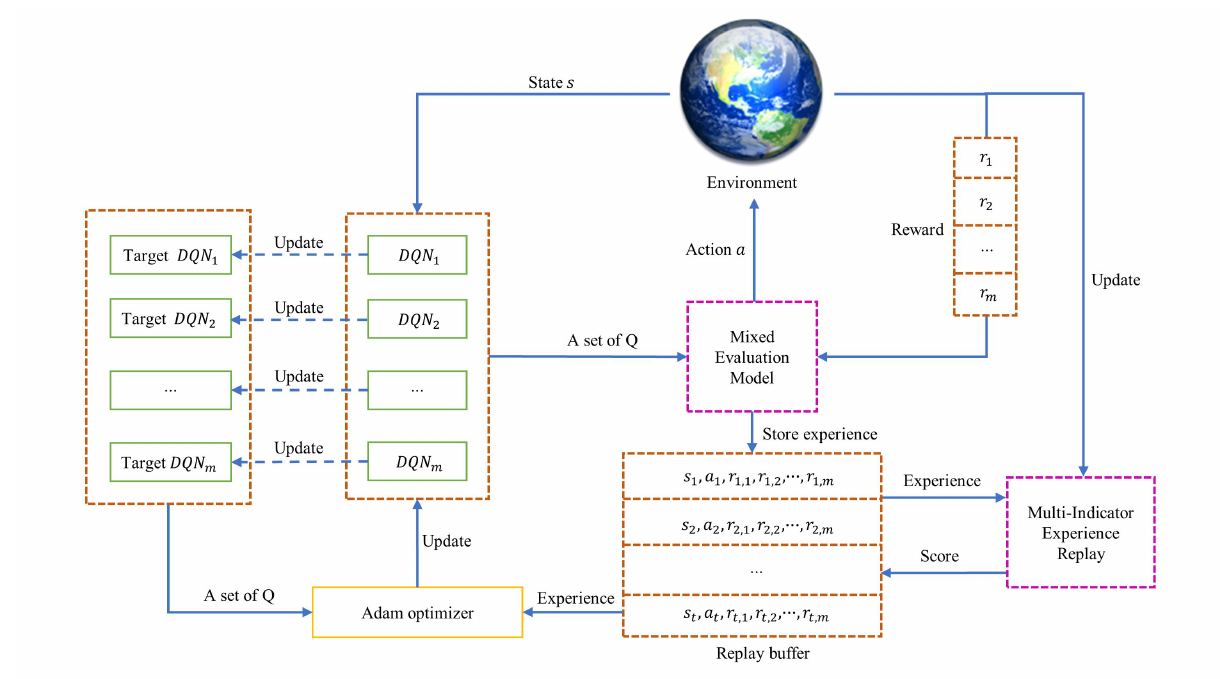
Figure 2. Architecture of